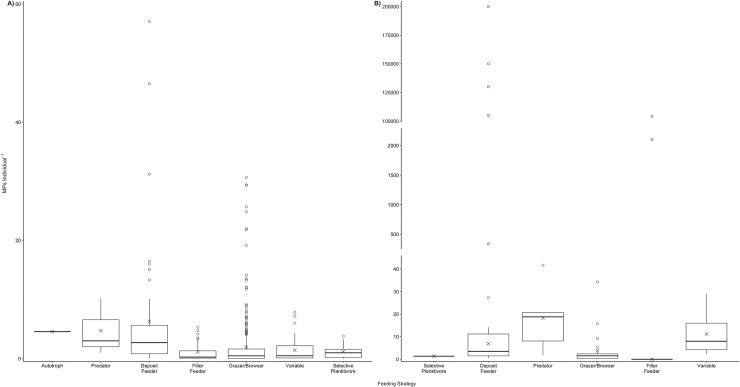
Body burden of bioaccumulated microplastics individual-1 estimated for different feeding strategies, based on reports for marine species collected in situ (a), and exposed in laboratory experiments (b). Data have been organised into feeding strategies and presented to show the minimum, first quartile, median, mean (X), third quartile, maximum and outliers (°). Note different scales on y-axes. Mean (X) values for (b) laboratory conditions are exclusive of outlier values.